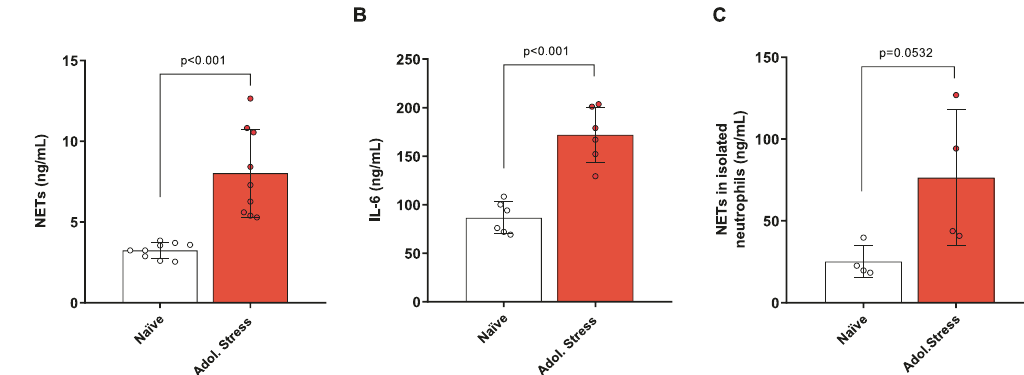
Fig. 5 Effect of stress during adolescence on levels of IL-6 and NETs measured in the plasma and bone marrow of rats. A NETs (ng/mL) levels are signi fi cantly elevated in the serum of adolescent stressed rats. B IL-6 levels (ng/mL) are signi fi cantly elevated in the serum of adolescent stressed rats. C Freshly neutrophils isolated from the bone marrow of adolescent stressed rates tended to produce more NETs than controls. T-test analysis. Data are expressed as mean ±